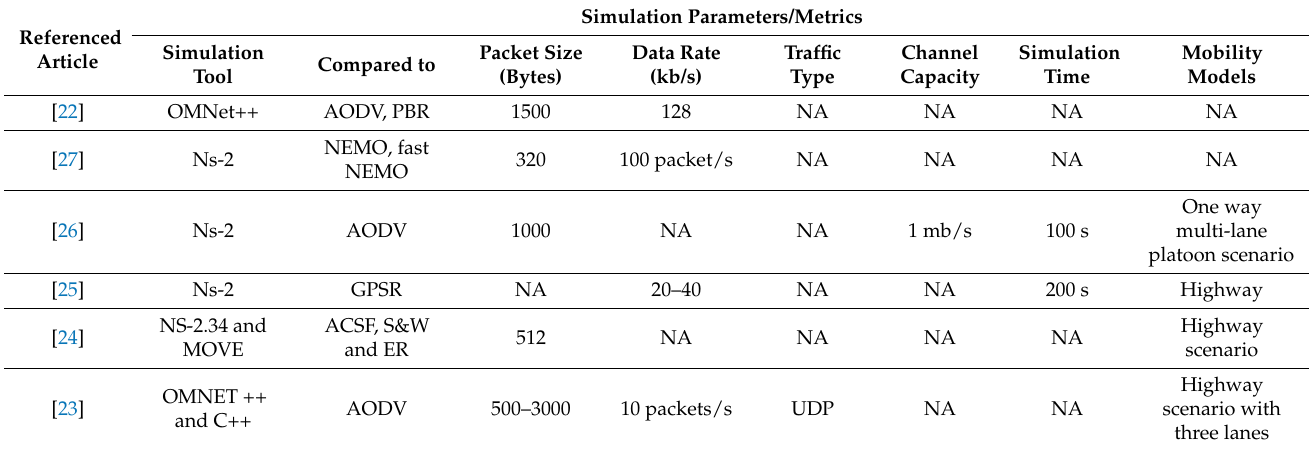
Table 3. Simulation parameters of highway based scenario routing protocols.